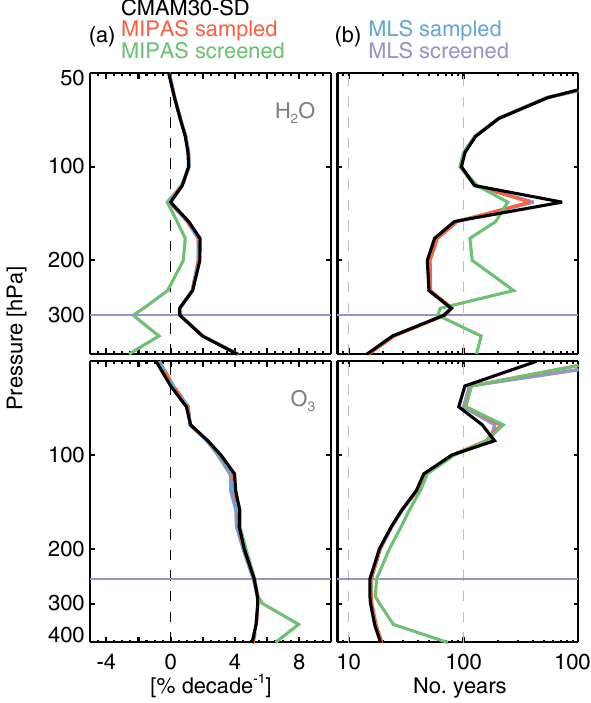
Figure 8. (a) H 2 O and O 3 trends computed based on monthly zonal mean deseasonalized anomalies for the tropics (20 ◦ S to 20 ◦ N) us- ing the raw model fields, all the available satellite measurements (MIPAS or MLS sampled) and only those measurements passing the screening criteria (MIPAS or MLS screened). Note that for O 3 , we only use data starting from 2000 to capture the expected period of O 3 recovery. A purple line indicates the bottom (largest pres- sure) of the recommended range of the MLS retrievals. (b) Number of years required to detect such